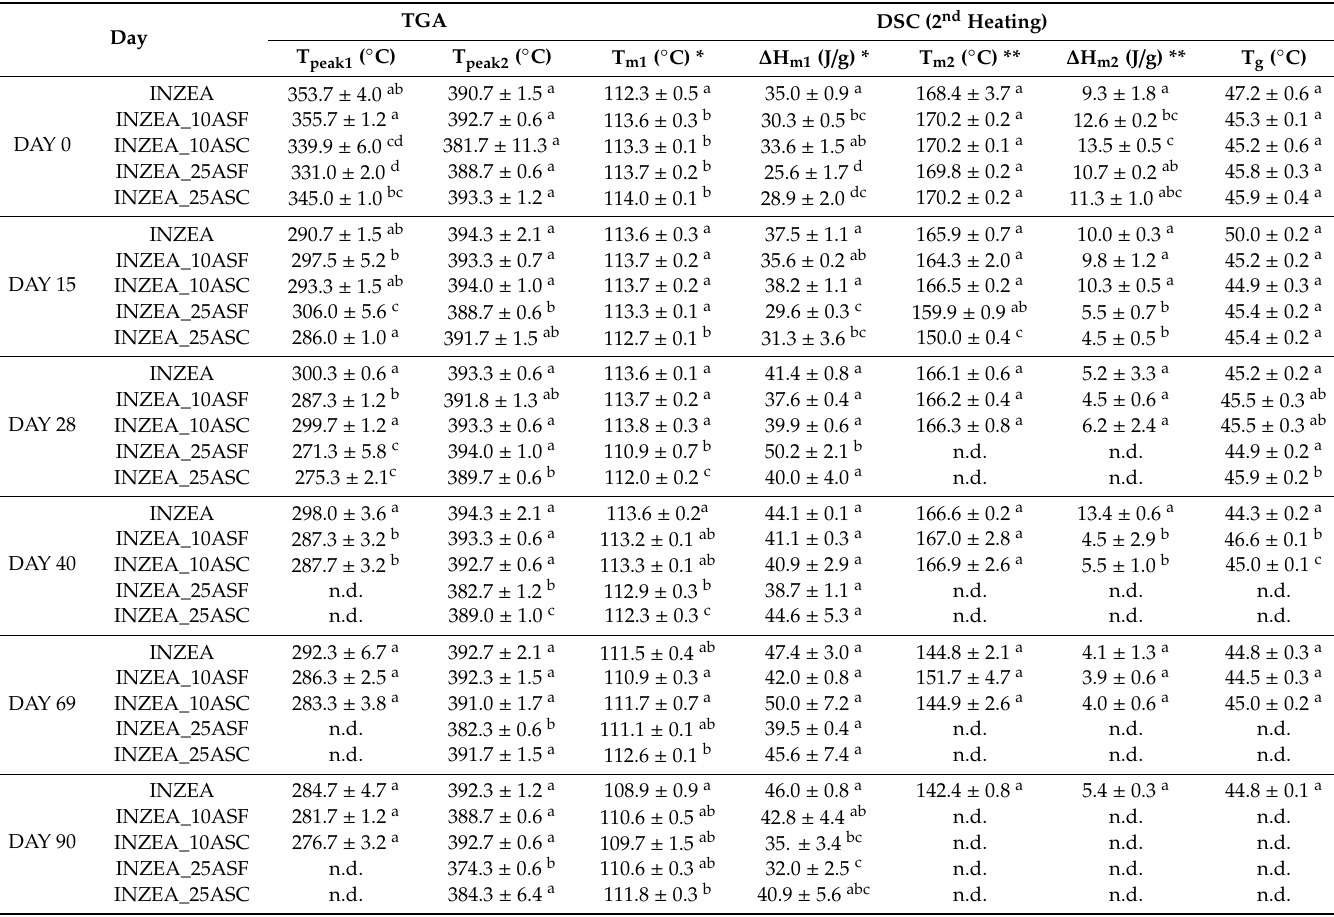
DSC: * and ** correspond to the first and second melting peaks appearing in Figure 8, respectively. Di ff erent superscripts (a, b, c, ab, abc) within the same day of study indicate statistically significant di ff erent values ( p < 0.05). T peak1 and T peak2 : first and second maximum degradation temperatures, respectively; T m1 and T m2 : first and second melting temperatures, respectively; ∆ H m1 and ∆ H m2 : First and second enthalpies of fusion, respectively; T g : glass transition